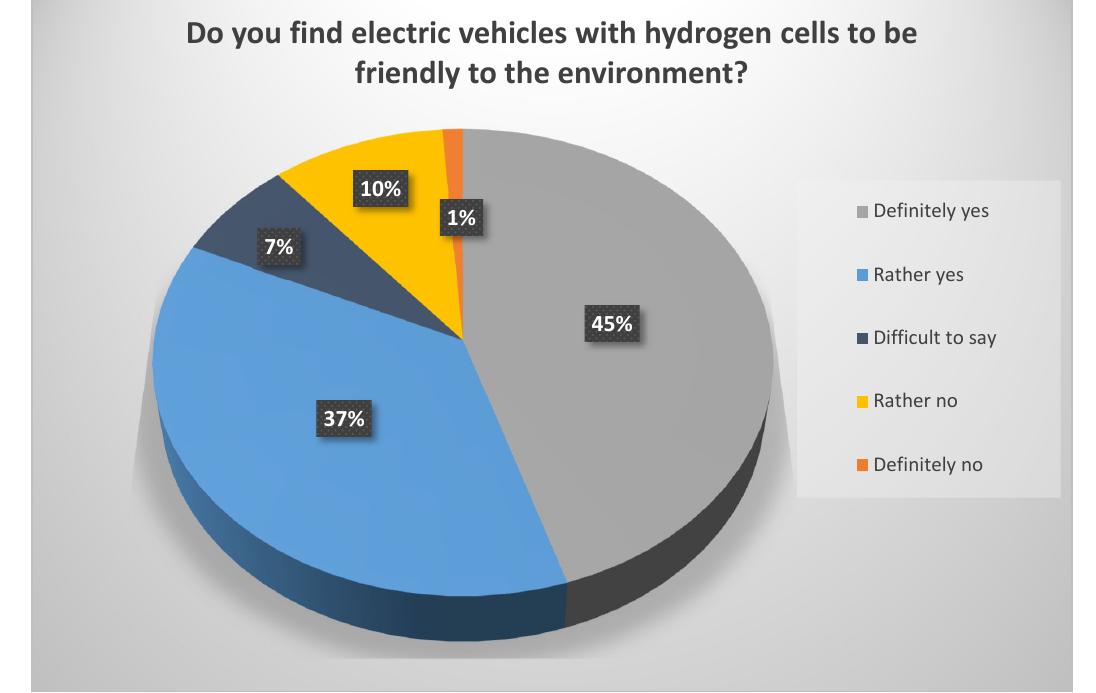
Figure 4. Survey question number 4. Source: own study.